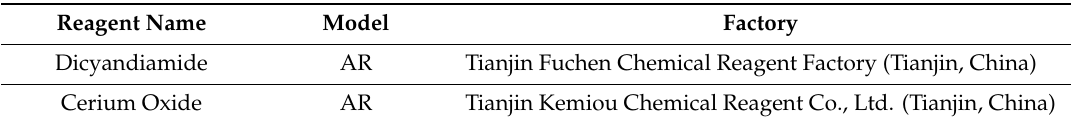
Table 2. Test raw